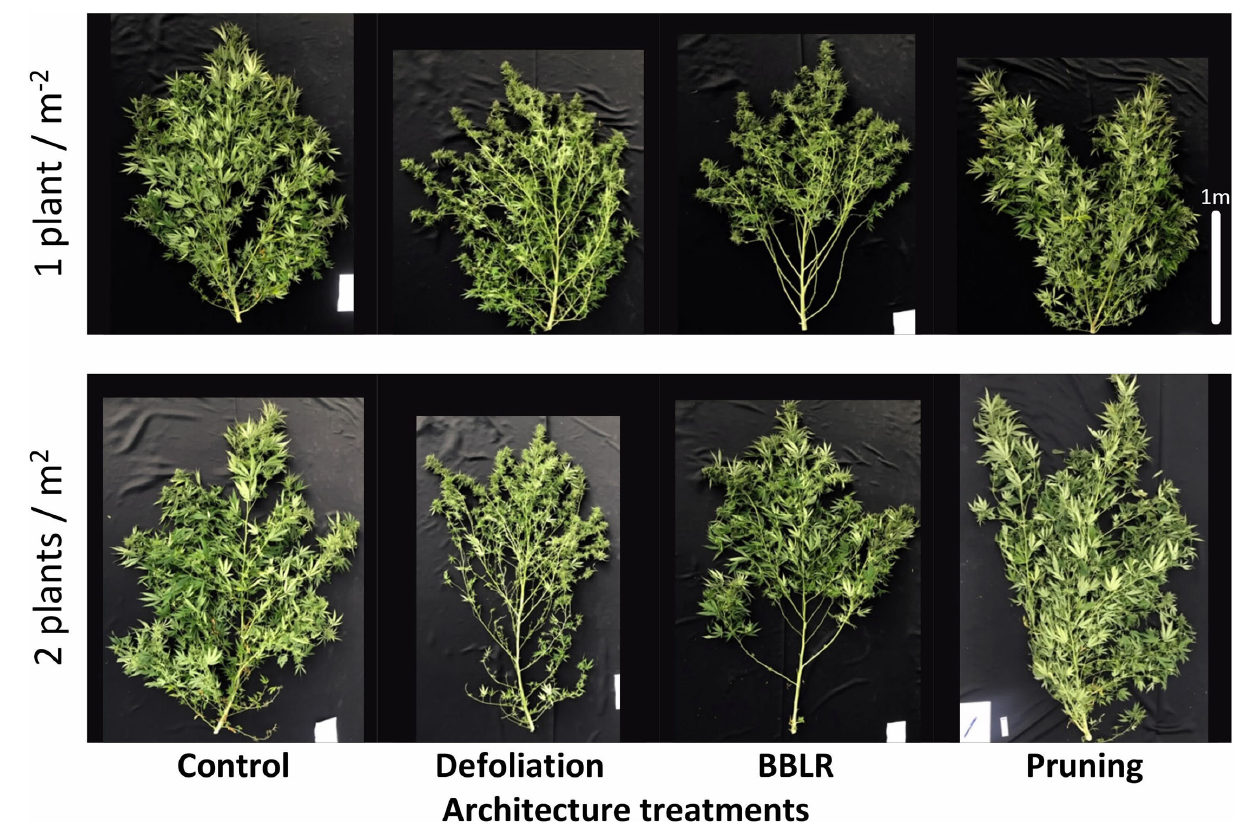
FIGURE 1 | Effect of planting density (1 or 2 plants m − 2 ) on visual appearance of medical cannabis plants, subjected to four plant architecture modulation treatments. Control, Defoliation, removal of leaves and branches from the bottom part of the plant [BBLR] at the transition to the flowering stage, and pruning at the beginning of the vegetative growth stage. The images were taken 69 days following the transition to the short photoperiod, at the time of harvest.